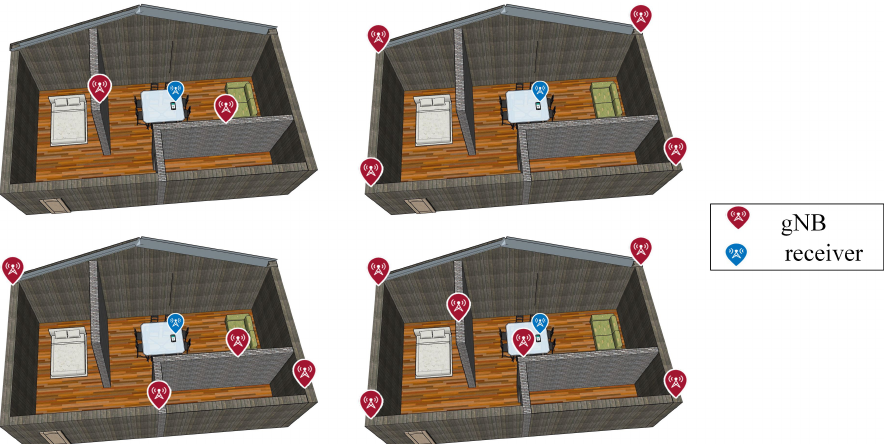
Figure 13. Schematic representation of different numbers and distributions of gNBs. Table 4. Positioning errors of base stations with different numbers and distributions. Number of